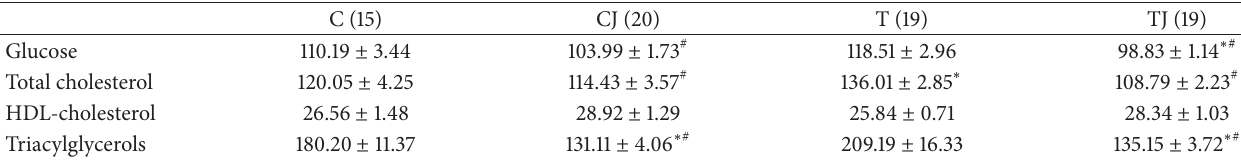
Table 3: Serum glucose, total cholesterol, HDL-cholesterol, and triacylglycerols in 21-day-old